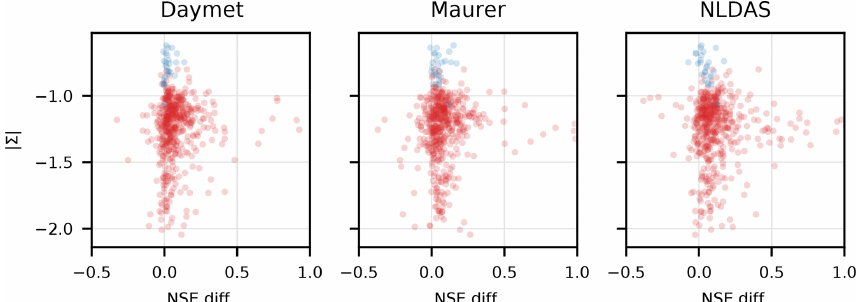
Figure C5. Fractional increase in NSE from the three-forcing model relative to the single-forcing models plotted against the log determi- nant of the covariance matrix of all three (standardized, log-transformed) precipitation products ( | (cid:54) | ). | (cid:54) | increases when there is a larger disagreement between the three data sets, approximating the joint entropy of the three products. With the exception of the anomalous NL- DAS basins (blue markers), the three-forcing model offers improvements with respect to the single-forcing models when there is larger disagreement between the three data sets. The three-forcing model learned to leverage synergy in these three precipitation